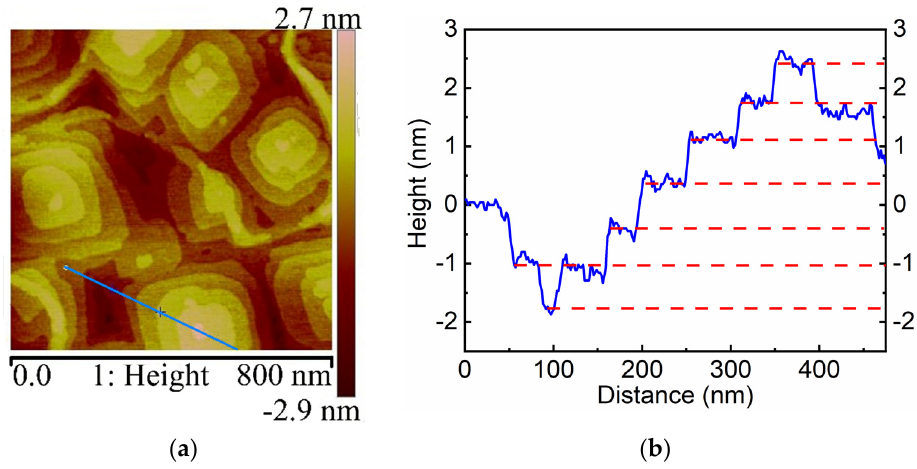
Figure 3. ( a ) AFM morphology of SnSe on a mica substrate. ( b ) The height profile along the blue line in ( a